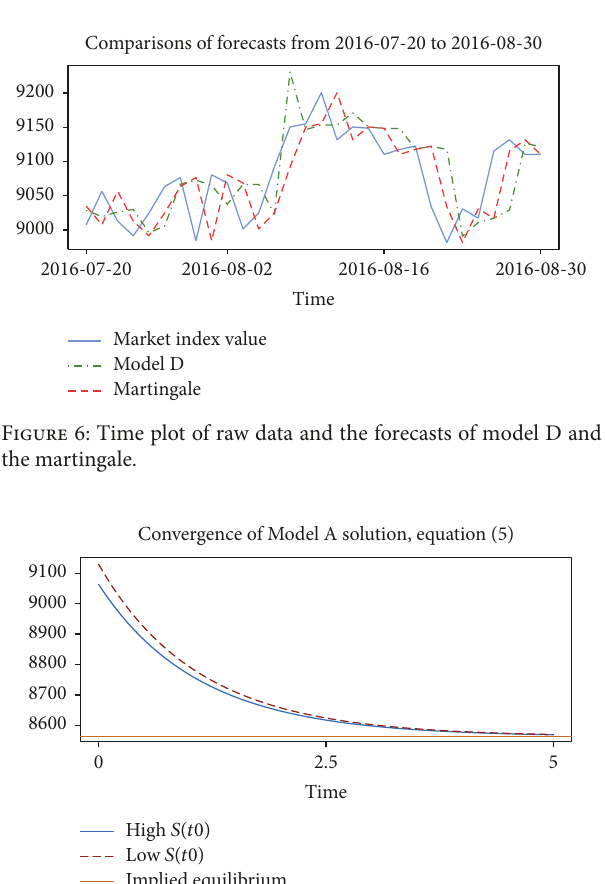
Figure 9: ACF and PACF of TAIEX daily returns from June 2, 2015, to August 31,